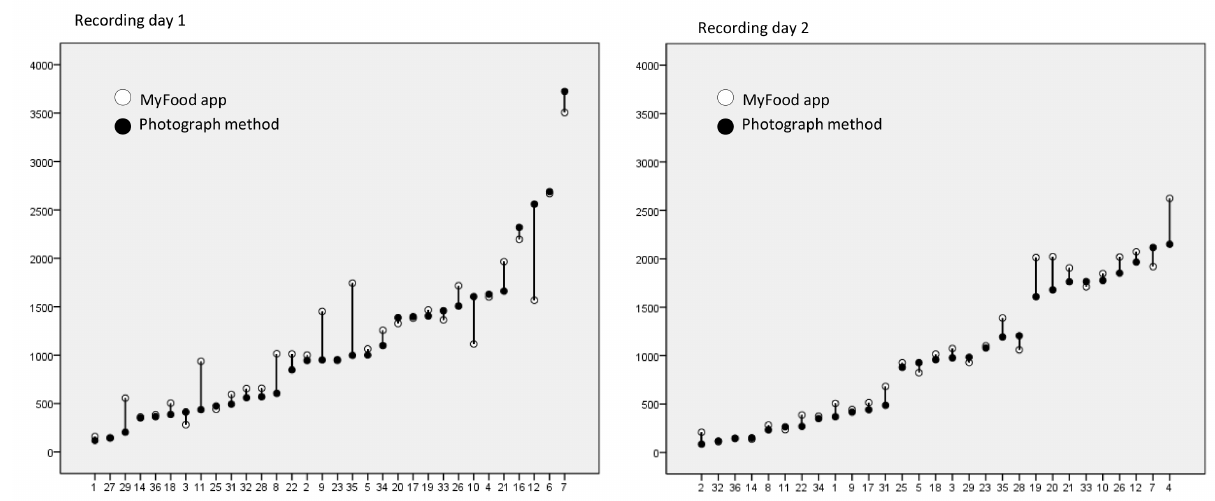
Figure 6. Drop plots illustrating individual intake of energy recording day 1 (n=32) and recording day 2 (n=29). Y-axis represents energy intake (kcal). X-axis represents participant number ranged with increasing energy intake according to the photograph method. Equal energy intake from app and photograph observations is presented with only black